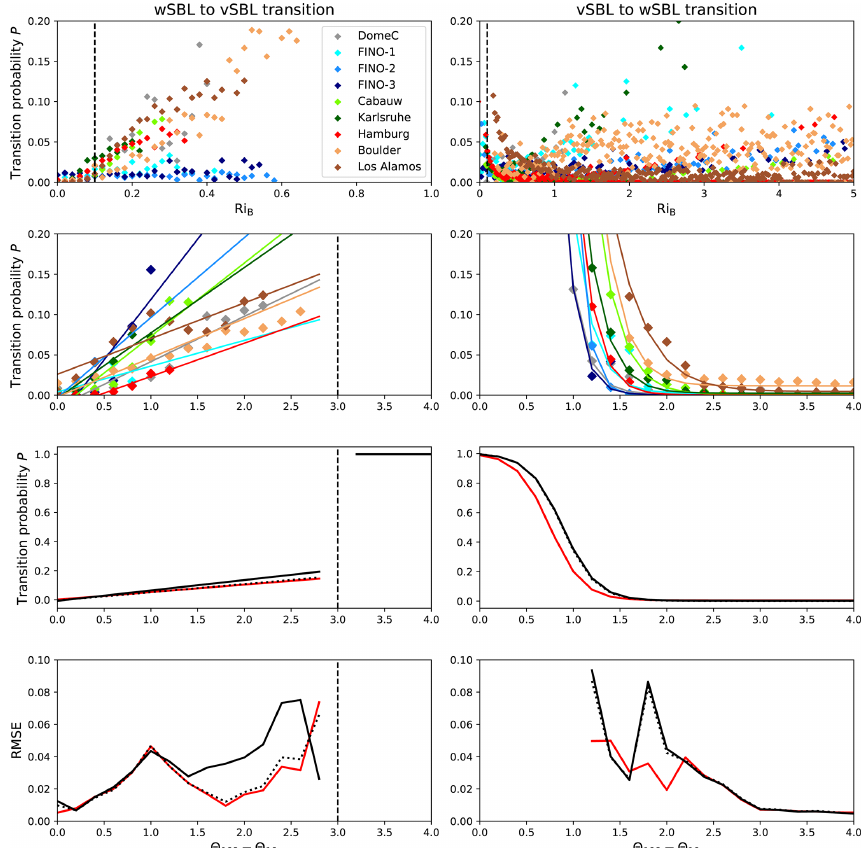
Figure 8. First row: probabilities for wSBL to vSBL (left) and vSBL to wSBL transitions (right) conditioned on the bulk Richardson number (binned by 0.02 increments; coloured diamonds). Second row: transition probabilities conditioned on the stratification ( (cid:50) 100 − (cid:50) s , (cid:50) 4 − (cid:50) s , and (cid:50) 100 − (cid:50) 30 for, respectively, land-, glacial-, and sea-based tower sites; binned by 0.2K increments) and best-fit curves. In order to reduce sampling variability in those panels, only data are considered for which the regime occupation probability in a bin exceeds 0.1% of all data within that regime. Third row: parameterization of the state-dependent transition probabilities conditioned on stratification using the mean and median parameter sets of the curve fits (or solid and dotted black lines). The best fit estimated through all stratification data is displayed in red. Fourth row: root mean square error (RMSE) between the conditional transition probabilities as estimated from HMM analyses and the parameterized conditional transition probabilities. All transition probabilities have been normalized to 10min